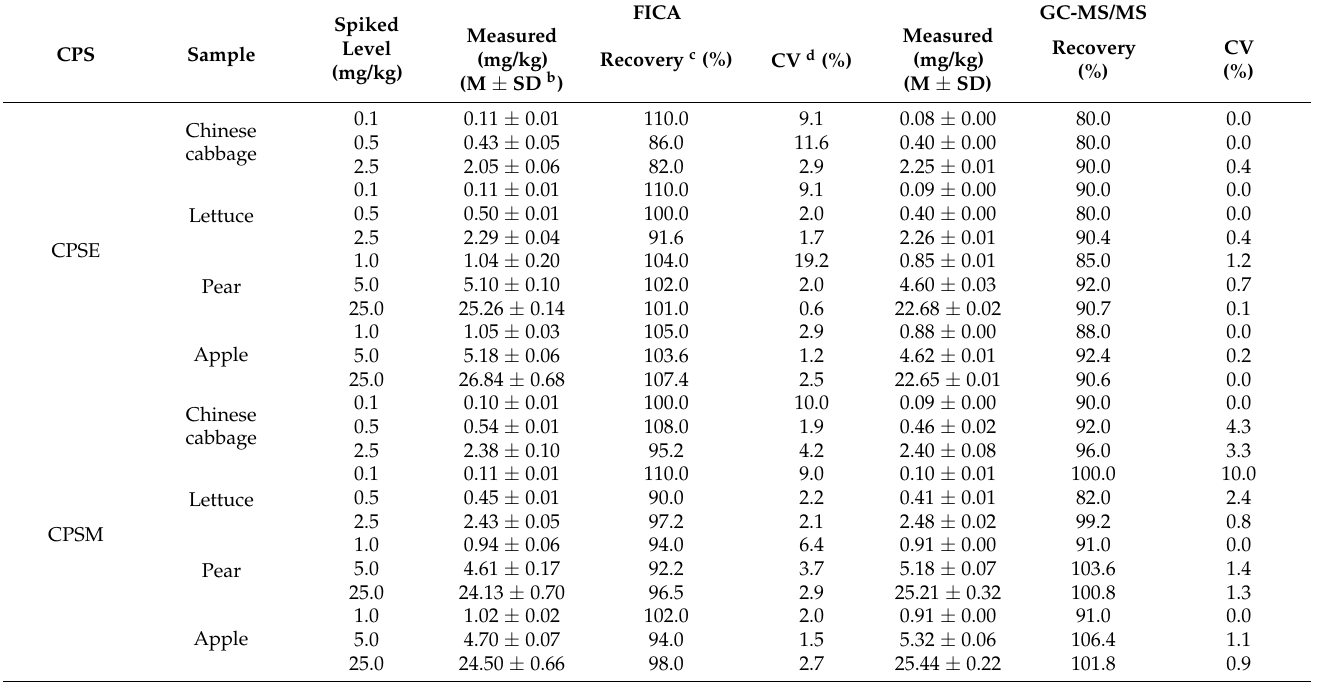
Table 3. Recoveries of CPS from spiked food samples by FICA and GC-MS/MS a ( n =